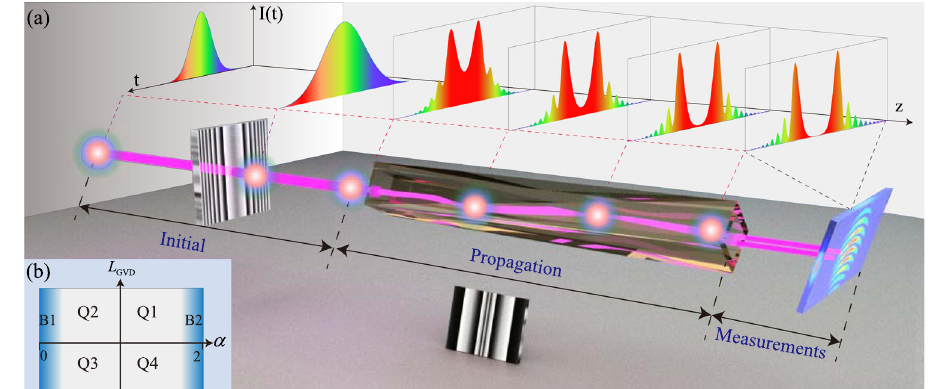
Fig. 1 | The setup used for the realization of the fractional Schrödinger equa- tion.a Intheinitialsection,thehologramisinstalledtoshapetheinputpulse.Inthe propagation section, the hologram inducing the spectral phase shift, which represents the effect of the fractional GVD, is used to emulate the propagation throughtheopticalLévywaveguide(forclarity ’ ssake,thishologramisdrawninthe rotated form, facing the fi gure ’ s plane). For the measurements, the single-shot spatial-spectrum interferometry technique is used to measure the pulse ’ s